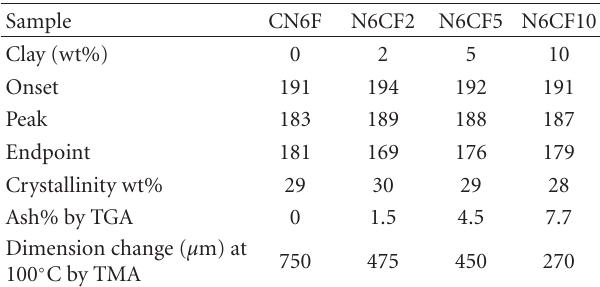
Table 2: Nylon 6 film DSC